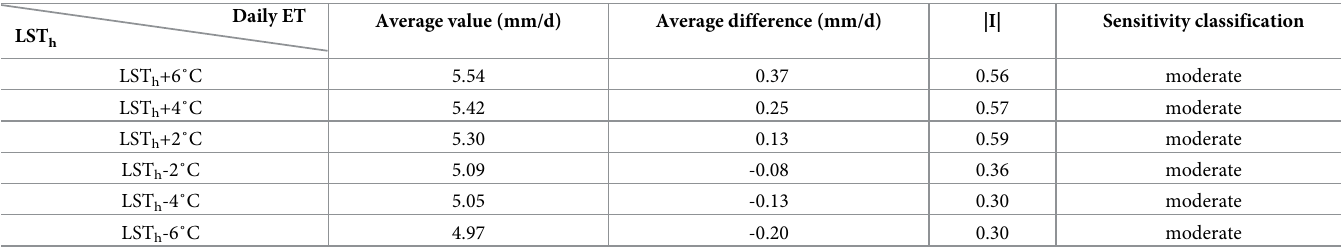
LST h -6˚C ET, evapotranspiration; LST h , hot surface